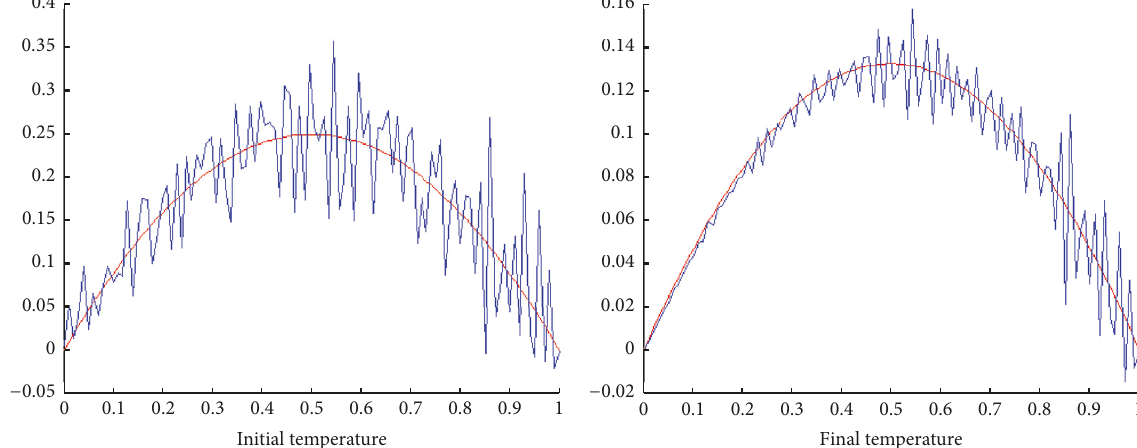
Figure 18: This figure shows that we cannot rebuild the solution.